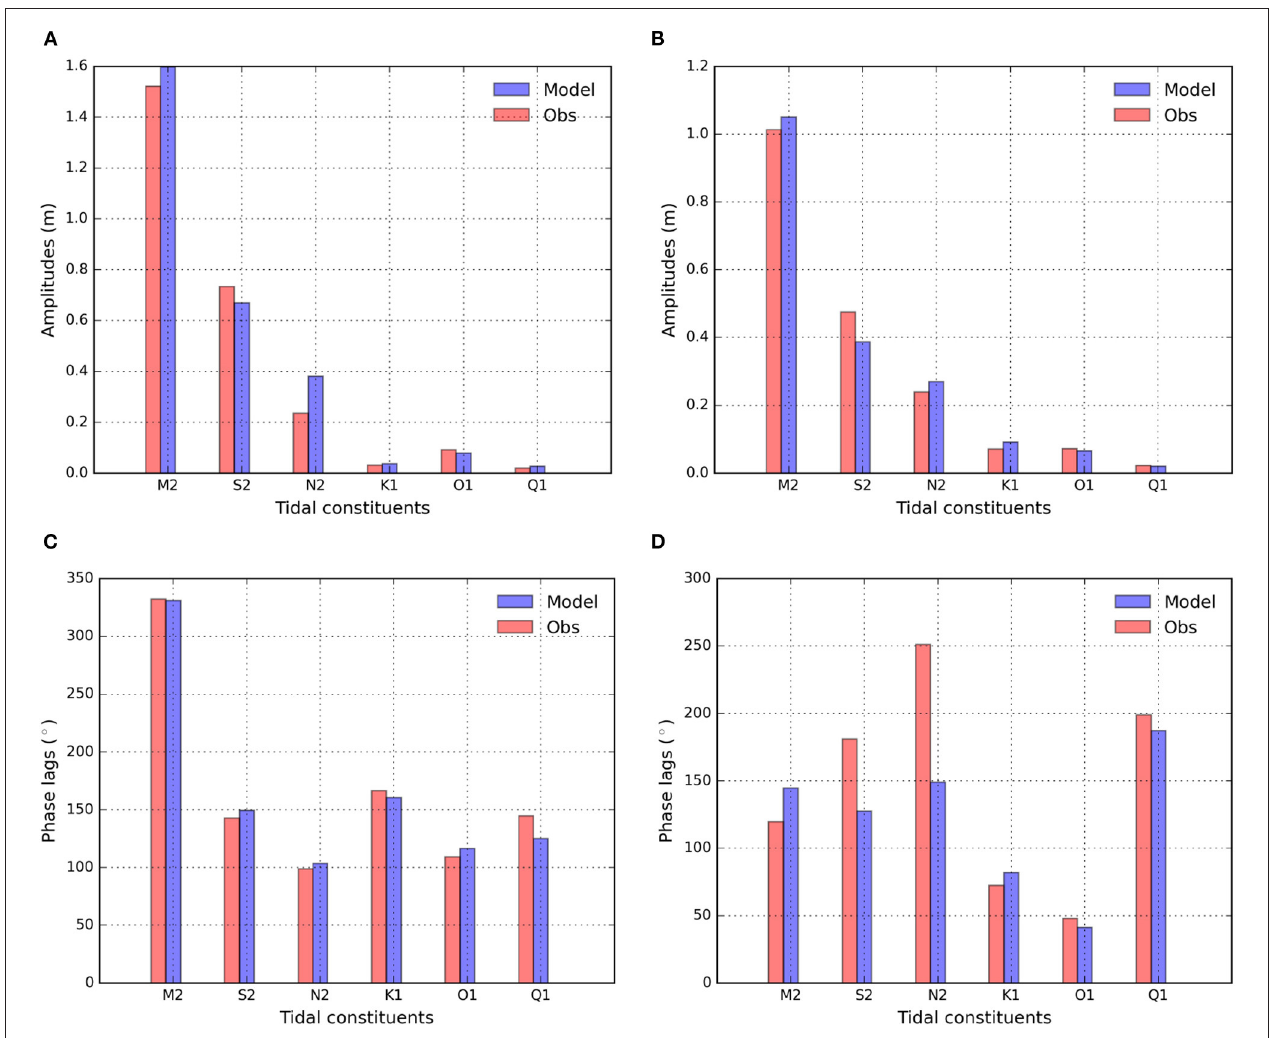
FIGURE 4 | Statistics of the mean tide amplitudes in March (A) and in August (B) from numerical simulations (blue) and tide gauge observations (red); and the corresponding mean phase lags in March (C) and August (D) averaged using four tide gauges (see Table 1 ).